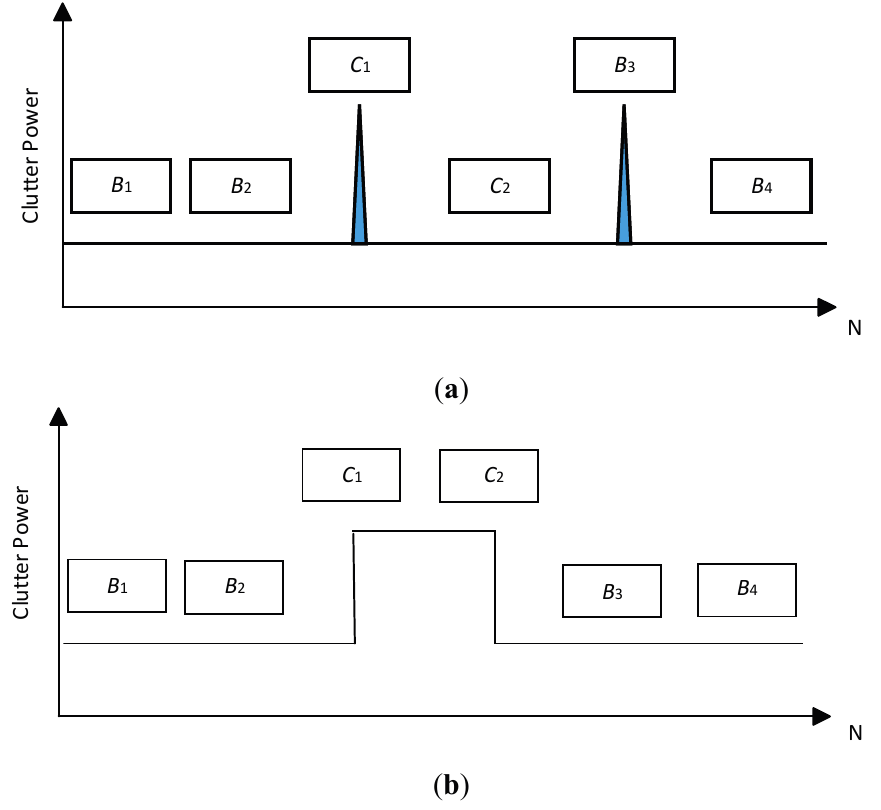
Figure 1. Sketch of non-homogenous background ( a ) The background with interferences; ( b ) The background with straddling clutter.